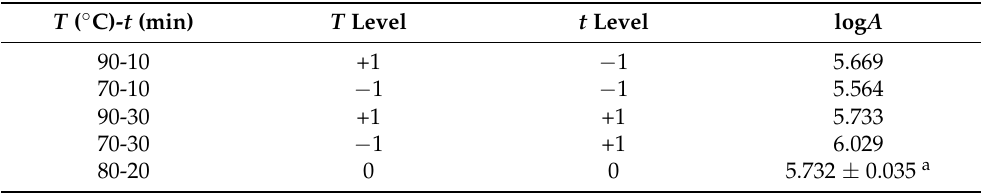
Table 1. Synopsis of the applied Design of the Experiment, variables (temperature and time), levels, and response (log A